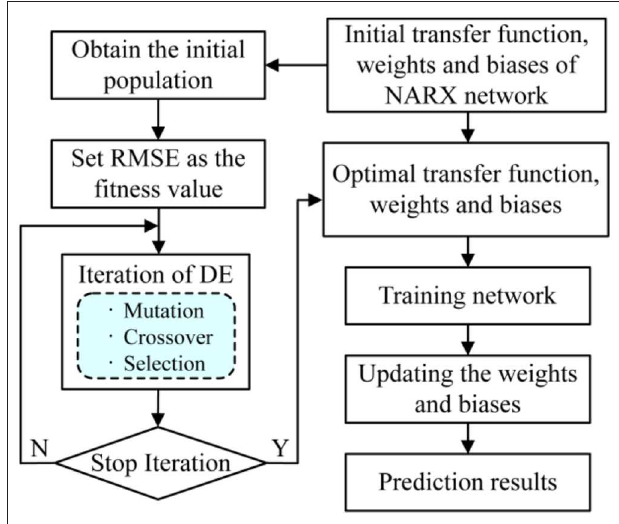
FIGURE 6 | The optimization procedure of differential evolution algorithm (DEA) for NARX network model.